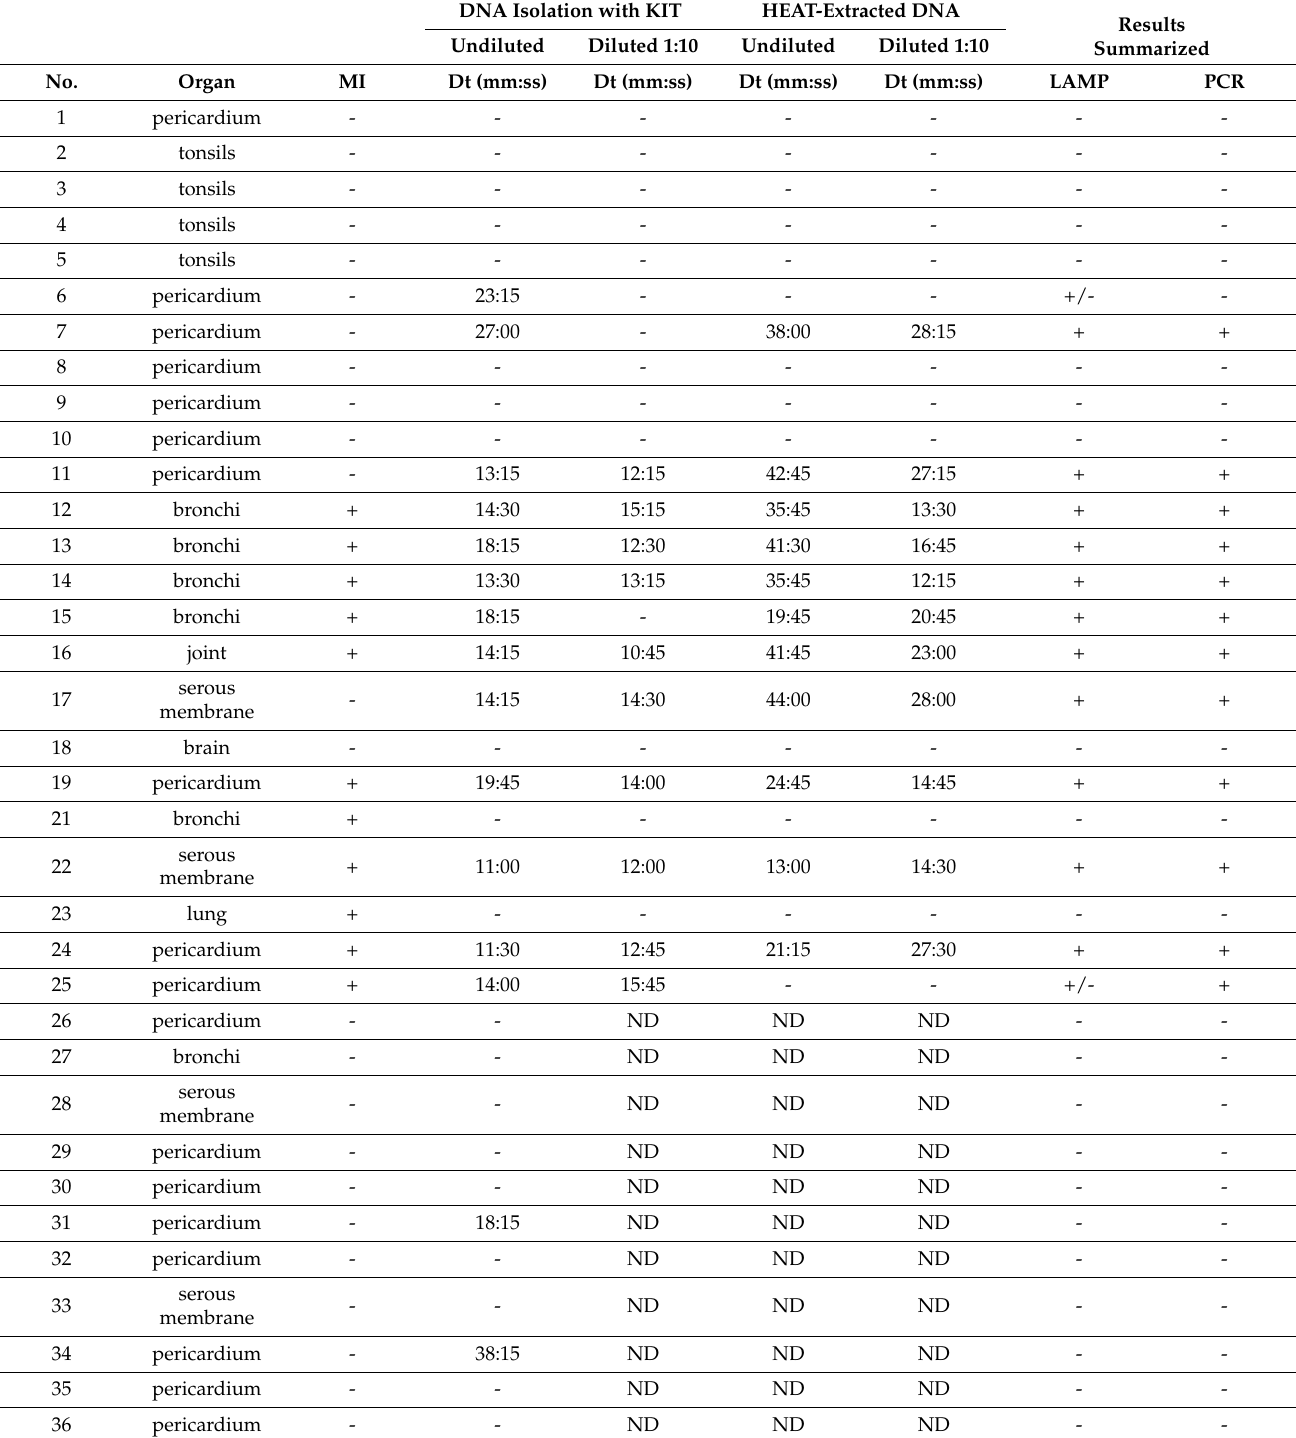
Table 5. Results of 36 swab samples from different organs of pigs tested with the LAMP assay and a conventional PCR assay including a comparison of two different DNA extraction methods and diluted versus undiluted